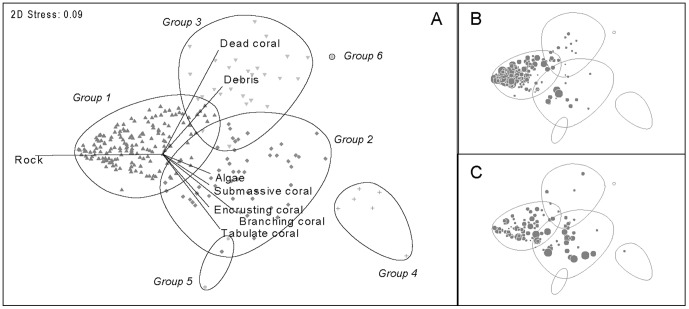
Two-dimensional MDS of the reef stations based upon habitat variables.
A. Station plot showing the most determinant sediment type/substratum coverage variables (correlations >0.4). Same plots with grey circles proportional to the density of B.
Trochus niloticus (adults) and C.
Tridacna maxima.